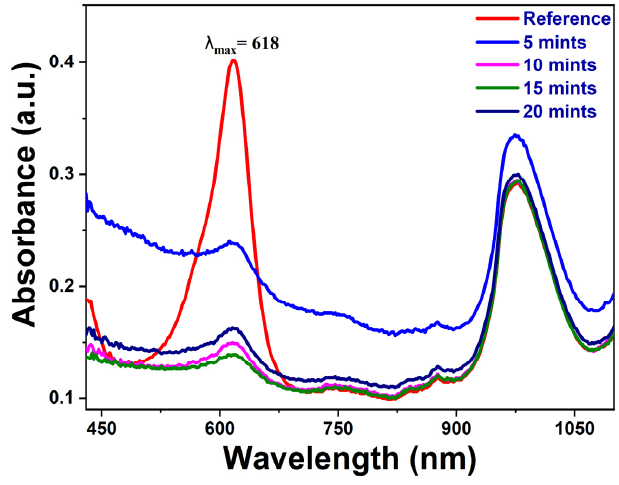
Figure 2. Time-dependent UV-Visible spectra of MG during adsorption process.